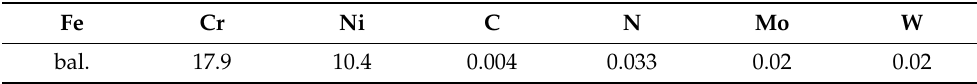
Table 1. Chemical composition (in wt.%) of the investigated alloy. Fe Cr Ni